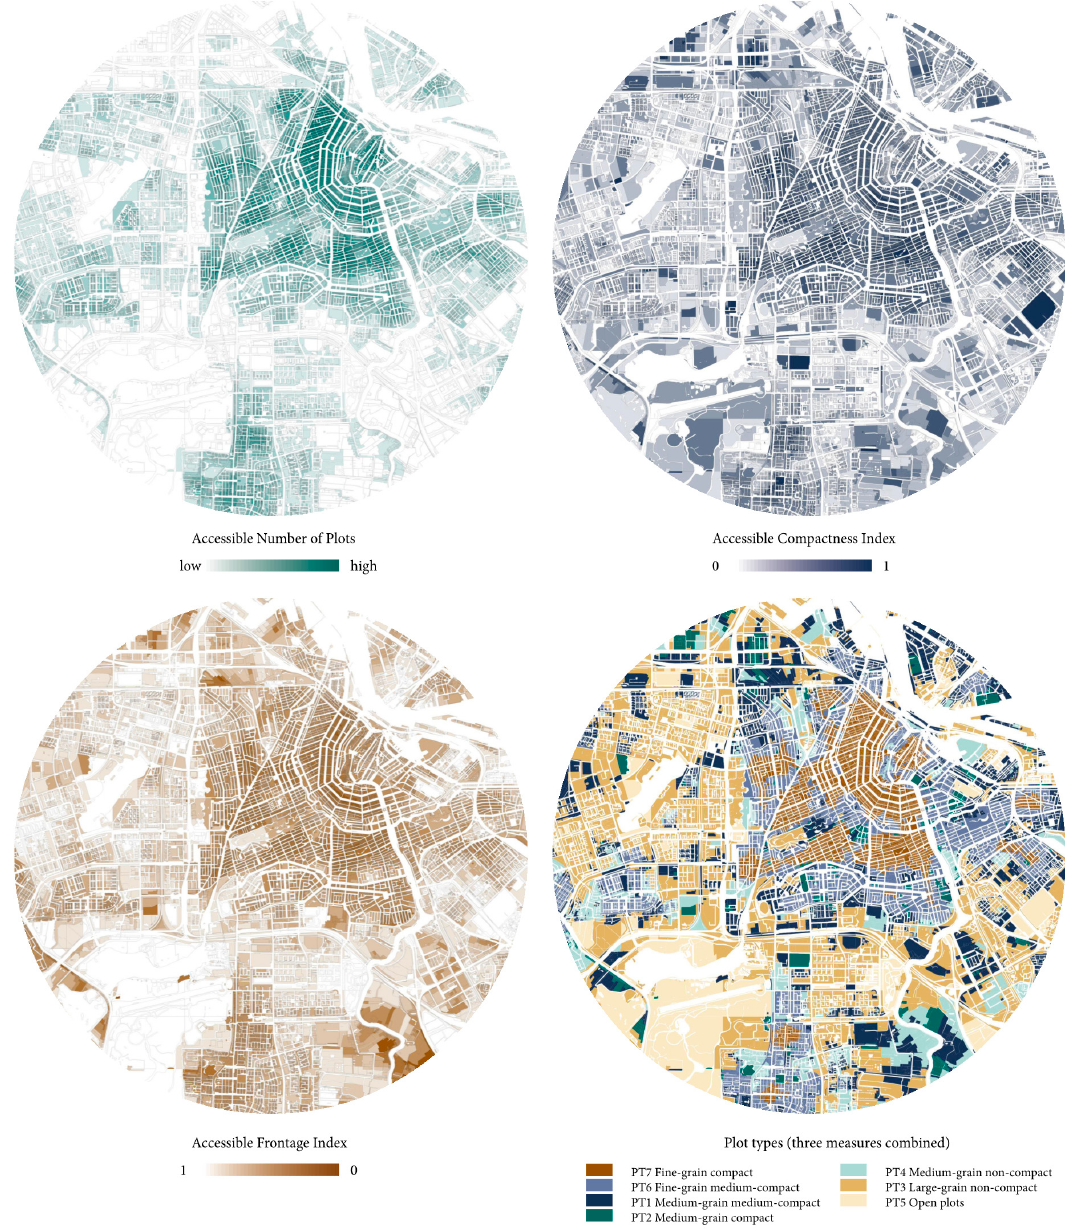
Figure A3. Amsterdam. Overview of three plot measures (accessible number of plots, accessible compactness index, accessible frontage index) and seven plot types that combine these three measures.